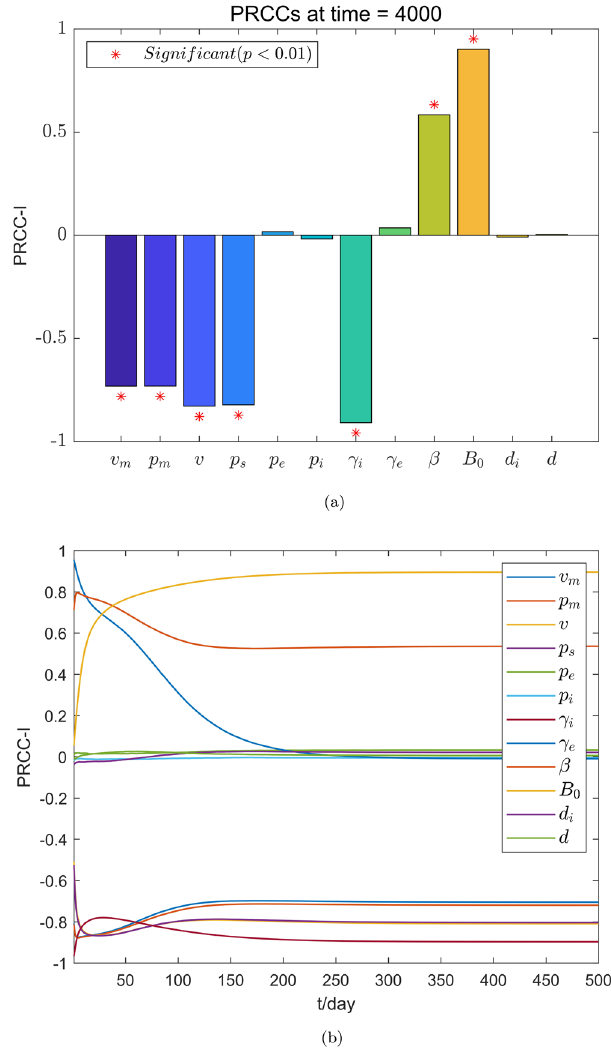
Figure 4. The PRCC value of each parameter to I ( t ). ( a ) The PRCC value of the parameter to I ( t ) at time t = 4000 . ( b ) The PRCC value of the parameter against I ( t ) changes over